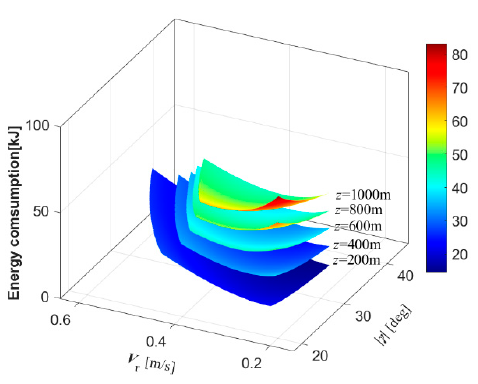
Figure 8. The energy consumption with different V r , | γ | and z .